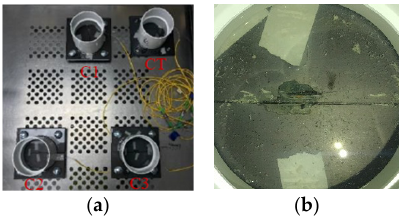
Figure 9. Experimental setup for corrosion-only tests: ( a ) corrosion-only test setup and ( b ) introducing artificial cracks on epoxy coating for accelerated localized corrosion.